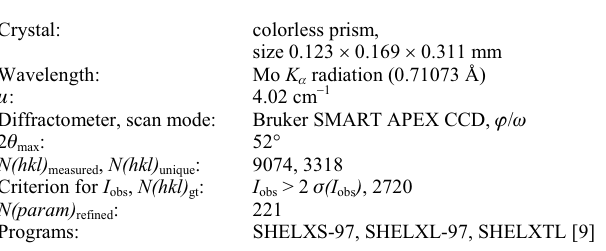
Table 1. Data collection and handling.